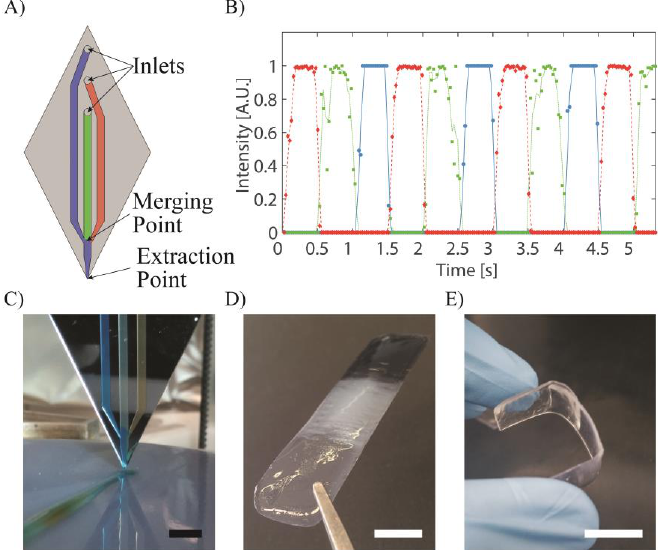
Figure 1. Multi-channel print head. ( A ) Schematic of the microfluidic channel design. ( B , C ) Switching of three colored liquids as recorded at the tip of the print head. ( D ) Clear, white and black part. ( E ) Two-hinges part printed with two different inks (one rigid and one flexible). All scale bars correspond to 1